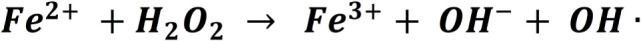
The Fenton reaction for the production of reactive oxygen species.